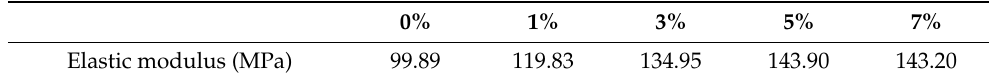
Figure 6. Tensile stress-strain curve of 5% GFRPU in the elastic range. Table 2. Elastic modulus of GFRPU according to glass fiber